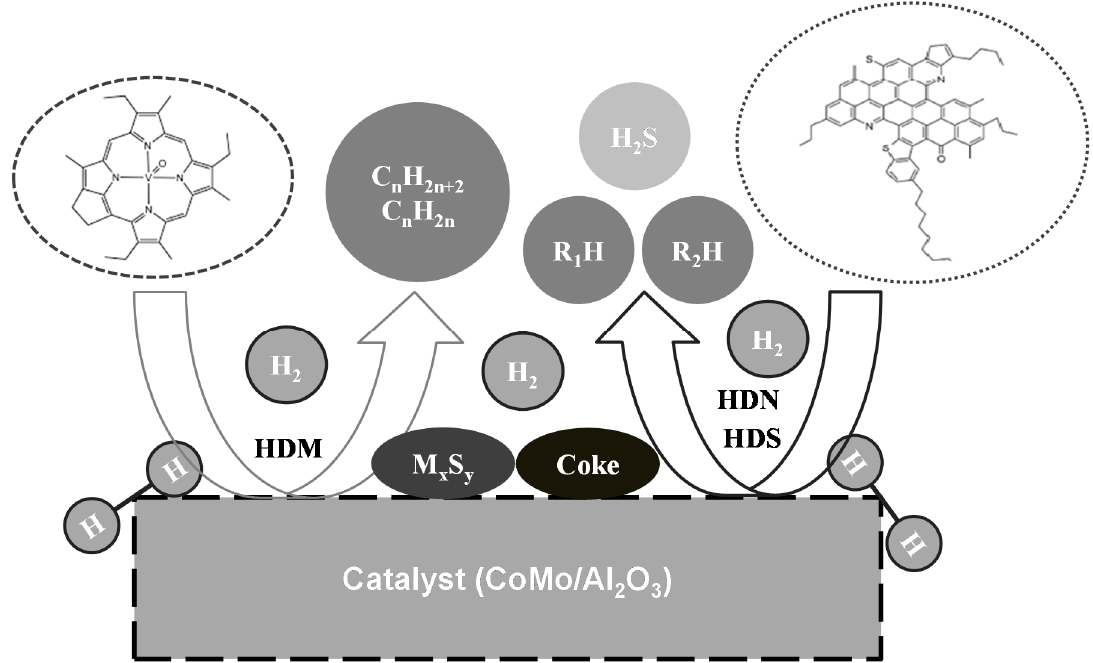
Figure 8. Typical interactions at catalyst surface for HDM and HDS reactions with hydrogen (metals such Ni and V are removed as metallic sulphides (i.e., M x S y , M is metal) and R 1 and R 2 are hydrocarbon intermediates).